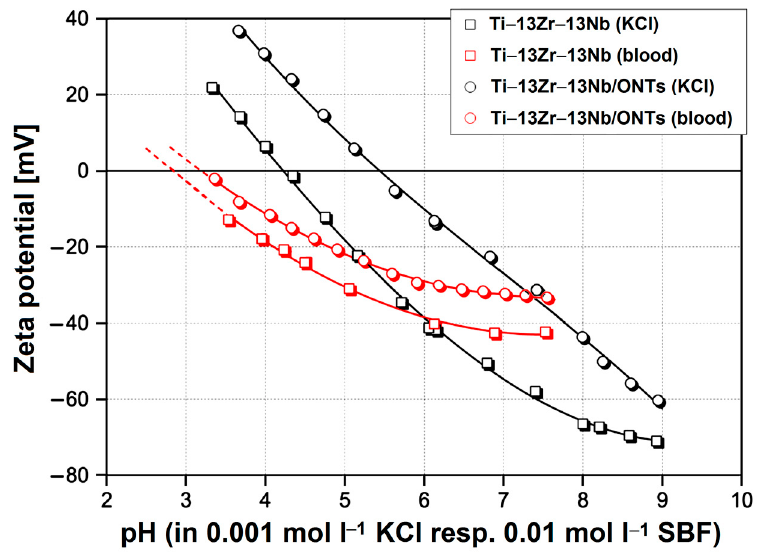
Figure 10. Dependence of electrolyte pH on zeta potential for the Ti–13Zr–13Nb alloy without and with the ONTs layer in 0.001 mol L − 1 KCl and 0.01 mol L − 1 simulated body fluid (SBF).